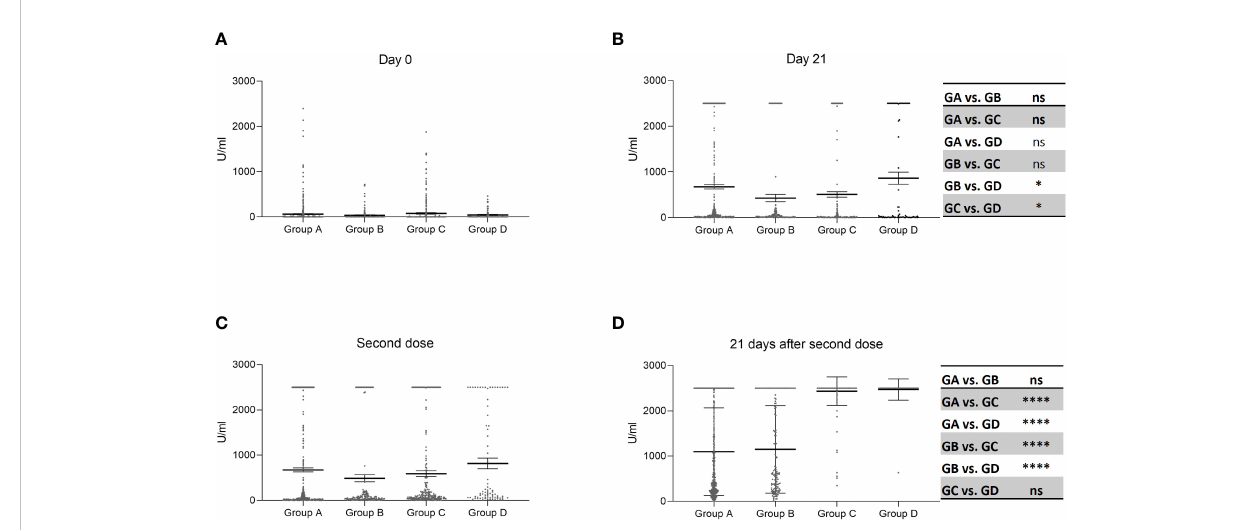
FIGURE 2 Levels of anti-S antibodies at each time point evaluation according to different immunization protocols. Horizontal lines indicate the mean ± standard error of the mean whereas points represent individual data. Kruskal-Wallis test and posthoc test for multiple comparison analysis; *, p <.05; **, p <.01; ***, p <.001; ****, p <.0001. Group A: two doses of the Sputnik vaccine separated by a 21-day interval Group B: two doses of the Sputnik vaccine separated by a 30-day interval. Group C: two doses of the Sputnik vaccine separated by a 70-day interval. Group D: First dose of the Sputnik vaccine, followed by a second dose of Moderna vaccine separated by a 107-day interval. (A) : Day 0 (T1, when administered the fi rst dose) no signi fi cant differences. (B) : 21 days after the fi rst dose (T2), Group D signi fi cantly different from Groups B (*) and C (*). (C) : On the day of the second dose (T3) no signi fi cant differences.. (D) : 21 days after the second dose (T4) Group A signi fi cantly different from Groups C and D (****), Group B signi fi cantly different from Groups C and D (****).